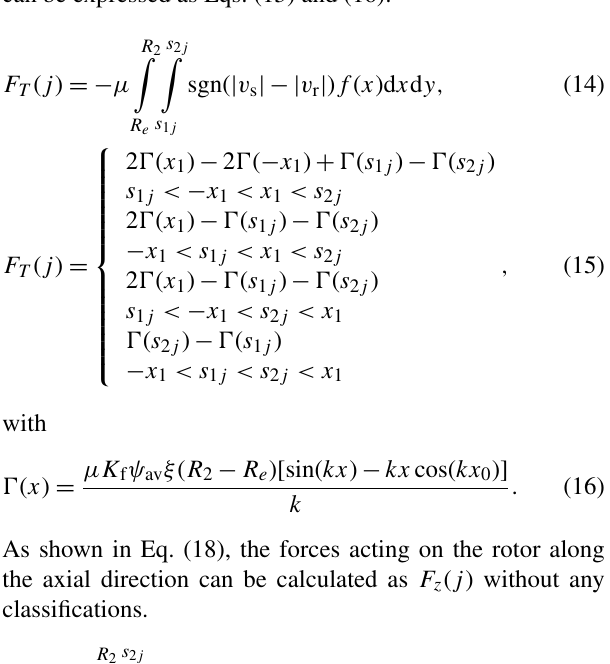
Figure 5. The teeth discretization implemented in the